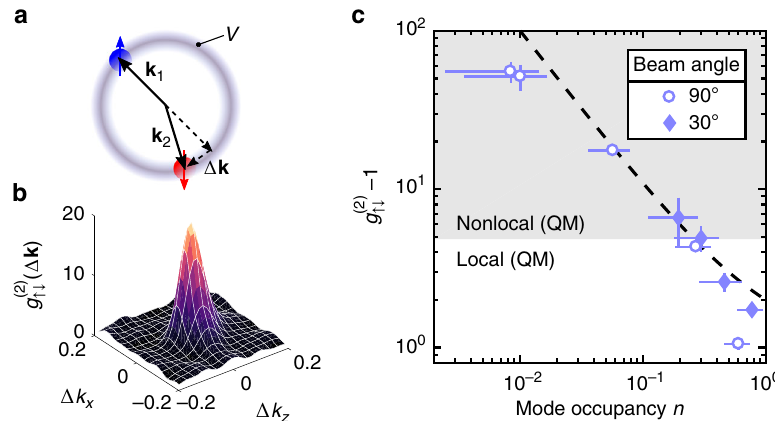
Fig. 2 Tunable momentum-spin anti-correlated atomic pair source. a Schematic of atoms with momentum and spin degrees of freedom in the scattering sphere. A 2D planar slice in momentum space is taken for simplicity. b Two-body cross-correlation function in momentum-spin g ð 2 Þ pair source with an average mode occupancy of n ¼ 0 : 058 ð 2 Þ , averaged over 2100 experimental runs. c The dependence of the degree of anti-correlation on the average halo mode occupancy. Two different angles between the Raman beams (30 (cid:7) and 90 (cid:7) ) were used to produce the experimental data. The dashed line depicts the theoretical prediction. Demonstration of Bell nonlocality strictly requires g ð 2 Þ prediction for the violation of CHSH inequality 18 . All error bars indicate the standard error in the mean